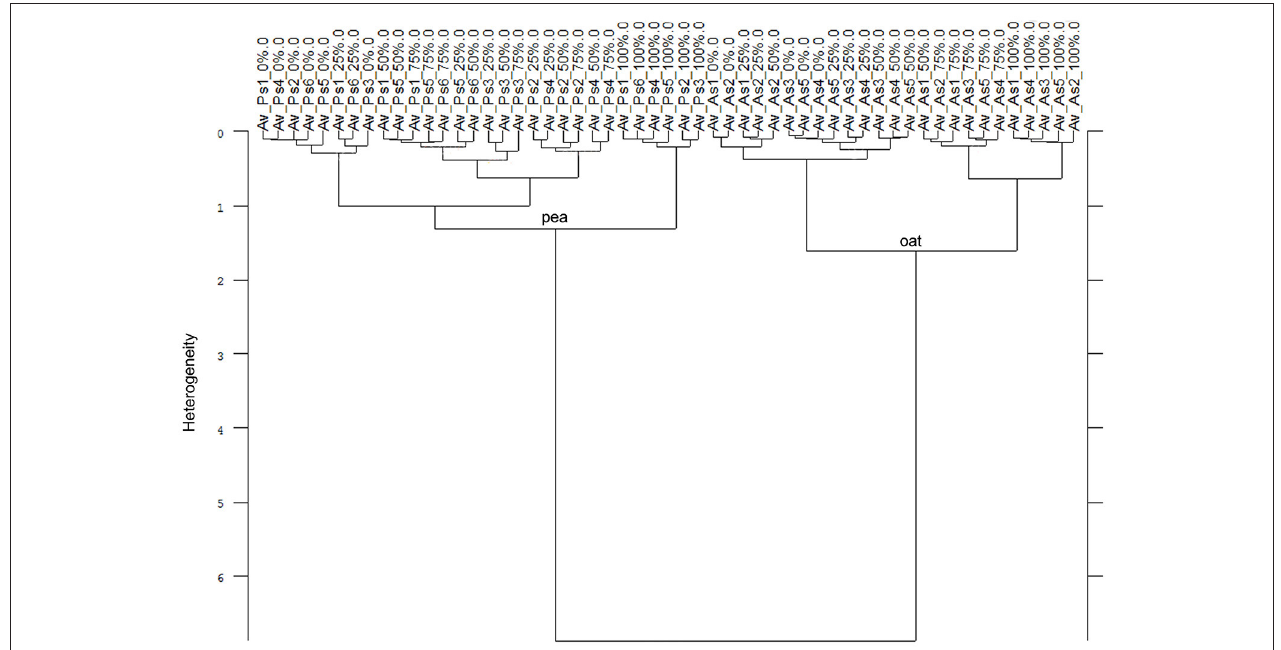
FIGURE 5 | Cluster analysis of the Av-spectra of all cultivars of the species Pisum sativum (Ps, pea) and Avena sativa (As, oat) for the united experiment 1 (exp. 1-1 and 1-2). Cluster analysis was evaluated with the first derivation and vector normalization of the reduced frequency range (3,751–2,749 cm − 1 and 1,801–599 cm − 1 ), Ward’s algorithm and Euclidian distance. The Av-spectra are averages (Av) of FTIR-ATR spectra of the different root segments (100% root tip, 0% root basis etc.; see Figure 1 for scheme, Table 2 for n, Table 1 for names of cultivars and proveniences).